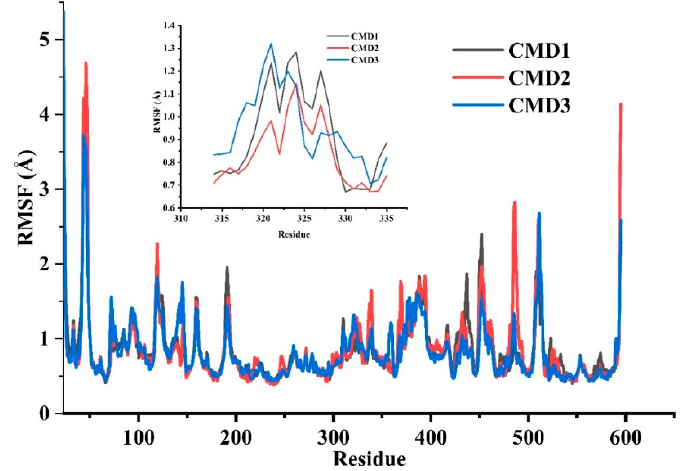
Figure 2. Root mean square fluctuations (RMSF) of an individual residue of O f Hex1 for three MD simulation repeats. CMD1 in black, CMD2 in red, CMD3 in blue.